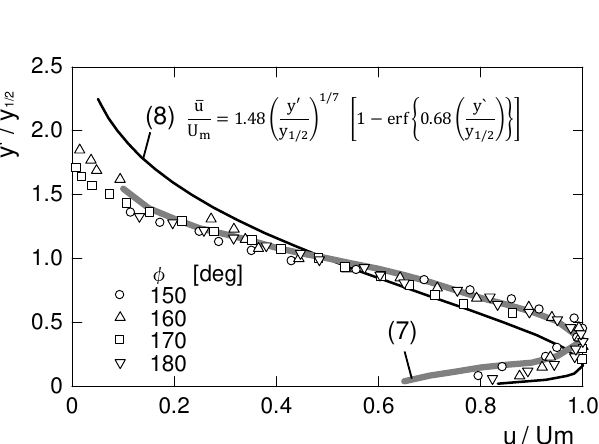
Fi g. 9 . Comparison between the reattachment flow and tur bulent wall